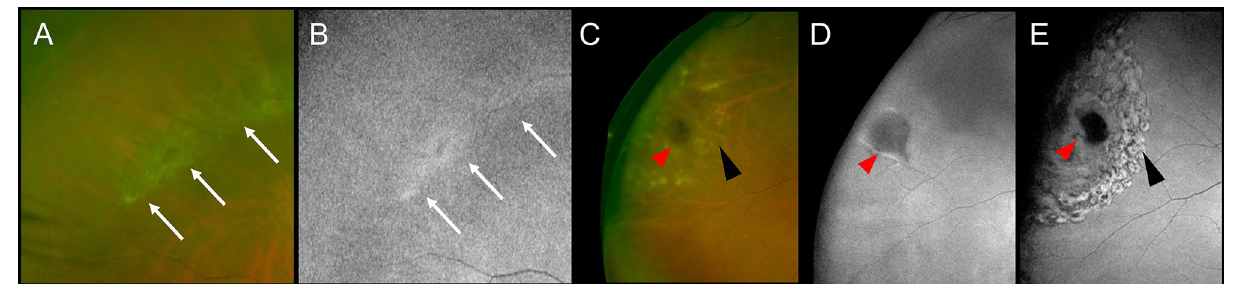
Figure 3. Green fundus autofluorescent (FAF) images of lattice degeneration (LD) and pigmentary lesion (PL). ( A ) and ( B ) LD in a non-detached retina of an eye with rhegmatogenous retinal detachment (RRD). The ultrawide field (UWF) scanning light ophthalmoscopy (SLO) image of LD ( A ). The green FAF shows normal to mild-hyper fluorescence in the LD lesion ( B ). White arrows indicate LD. ( C )–( E ) The PL seen in an original flap tear of another RRD-eye. The postoperative UWF SLO image shows the PL and retinal photocoagulation (PC) scars ( C ). The pre- and post-operative green FAF images of the PL in the original retinal flap tear, respectively ( D , E ). The PL shows hypofluorescence, which is distinguished from the appearances of the laser scars around the retinal tear. Red arrowheads indicate PL. Black arrowheads indicate PC